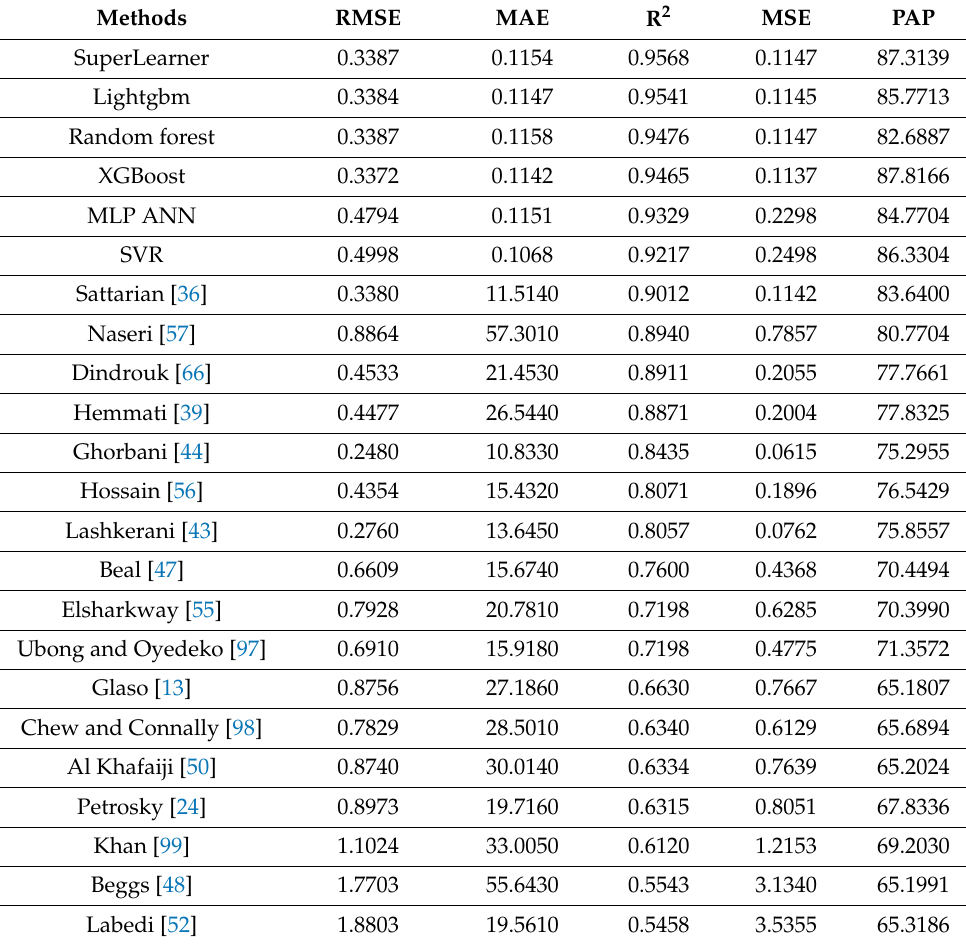
Table 4. Performance of µ od